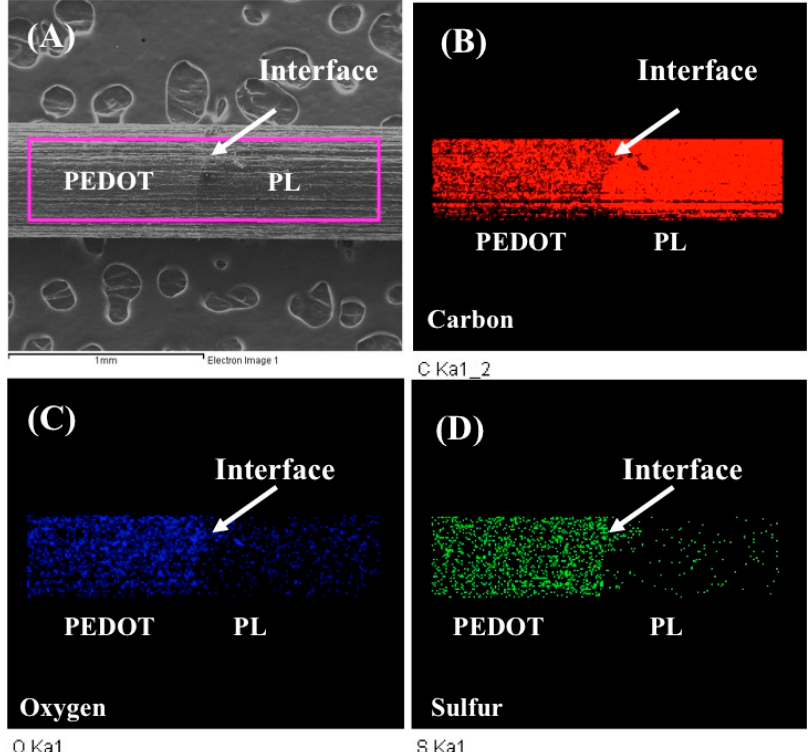
Figure 1. The surface images of PL and PEDOT/PL electrodes by SEM. ( A ) the interface between PEDOT film and uncoated PL. ( B – D ) the element mapping of carbon, oxygen, and sulfur for PL and PEDOT film, and PEDOT film, respectively.